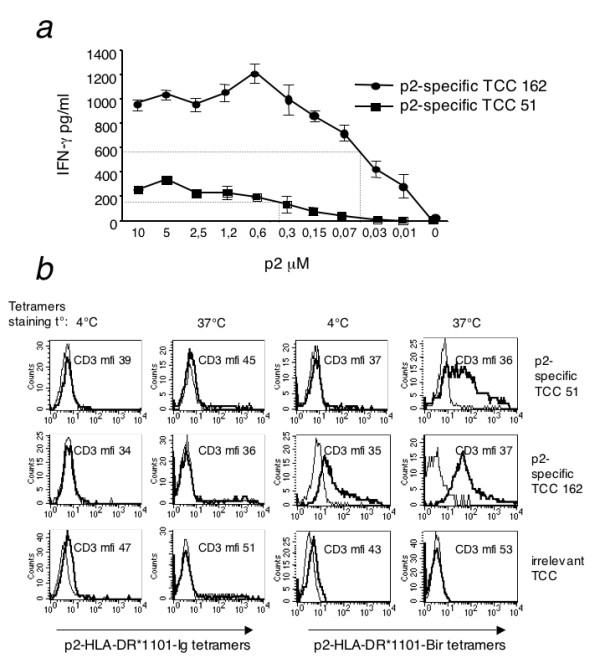
HLA-DR*1101-Bir, but not HLA-DR*1101-Ig, stain specific CD4+ T cells, and display a temperature-dependence. CD4+ TCC specific for p2, endowed with different affinity of recognition, and an irrelevant CD4+ TCC were stained with p2-loaded HLA-DR*1101-Bir tetramers at different temperature. (a) The relative affinity for the p2-HLA-DR*1101 displayed by the two TCC clones 162 and 51 is determined in an IFN-γ-releasing assay following production in response to different doses of p2 peptide. 104 T cells are incubated with 5 × 104 HLA-DR*1101 LCL cells and the indicated doses of p2 peptide. After 48 hours, the concentration of IFN-γ in the culture supernatant is measured by ELISA. Indicated are the concentration of p2 peptide required to elicit half-maximum release of IFN-γ in the two TCC. (b) Staining of TCC162, TCC51 and the irrelevant TCC with either p2-loaded HLA-DR*1101-Ig or p2-loaded HLA-DR*1101-Bir tetramers. Staining is performed for 2 hours at the indicated temperatures with 10 μg of tetramer per sample. The tetramer staining on CD3+CD4+ gated cells is shown. The amount of surface TCR, obtained by staining with anti-CD3 mAb, expressed by the TCC in the different conditions is shown by the mean fluorescent intensity (CD3 mfi).